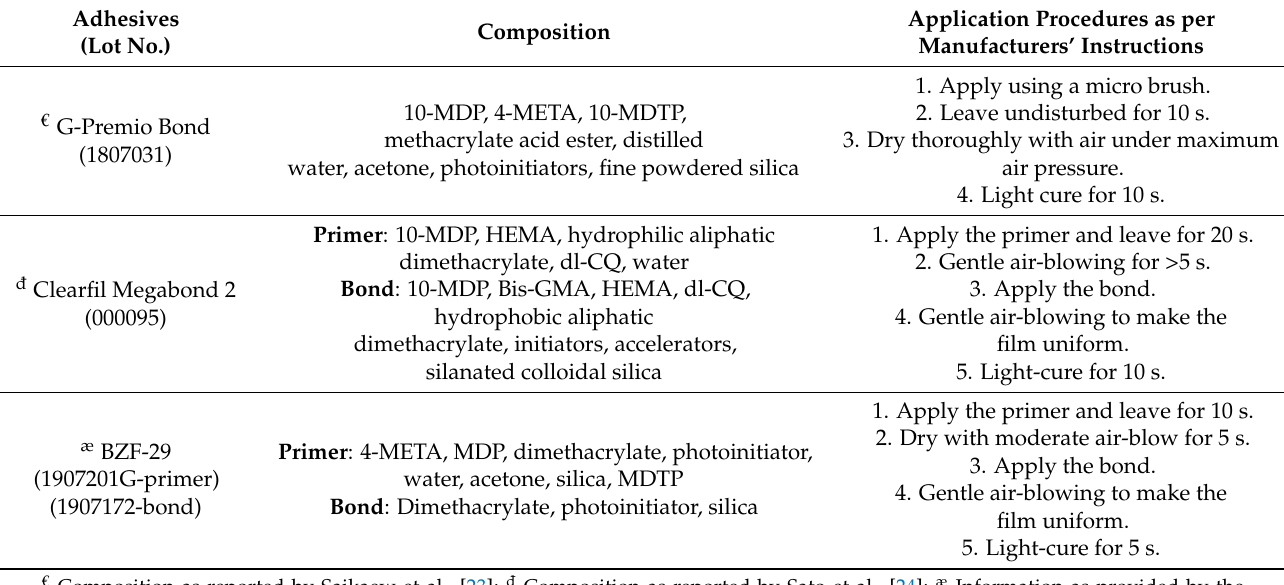
Figure 1. Schematic of specimen preparation and test set-ups for determining µ TBS, fracture mode, and interface characterization. * GP, G-Premio Bond; MB, Clearfil Megabond 2; BZF, BZF-29. Table 1. Adhesive systems (Lot number), composition, and application